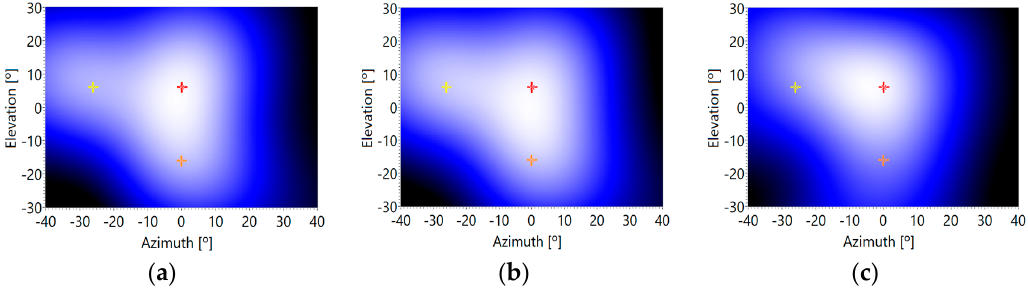
Figure 12. Acoustic image versus background noise levels: ( a ) minimum, ( b ) medium and ( c ) maximum.